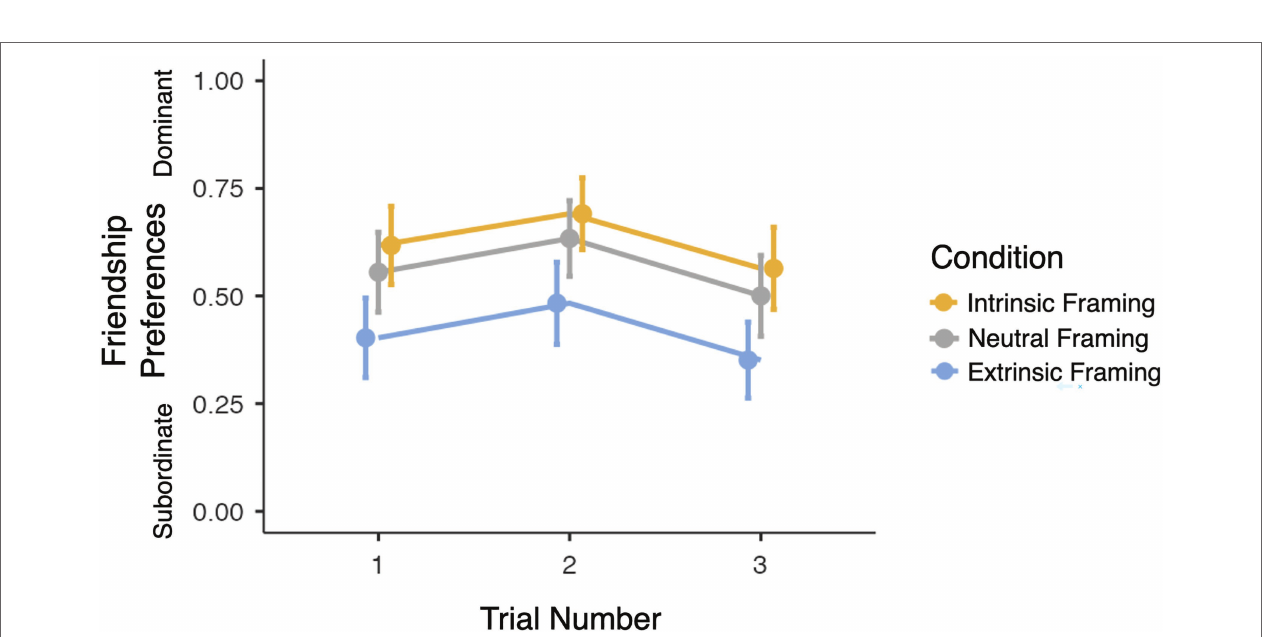
FIGURE 3 | Impact of framing condition and trial number on attributions. Higher scores reflect more personal attributions, and lower scores reflect more structural attributions. Error bars represent +/ − 1 SE.